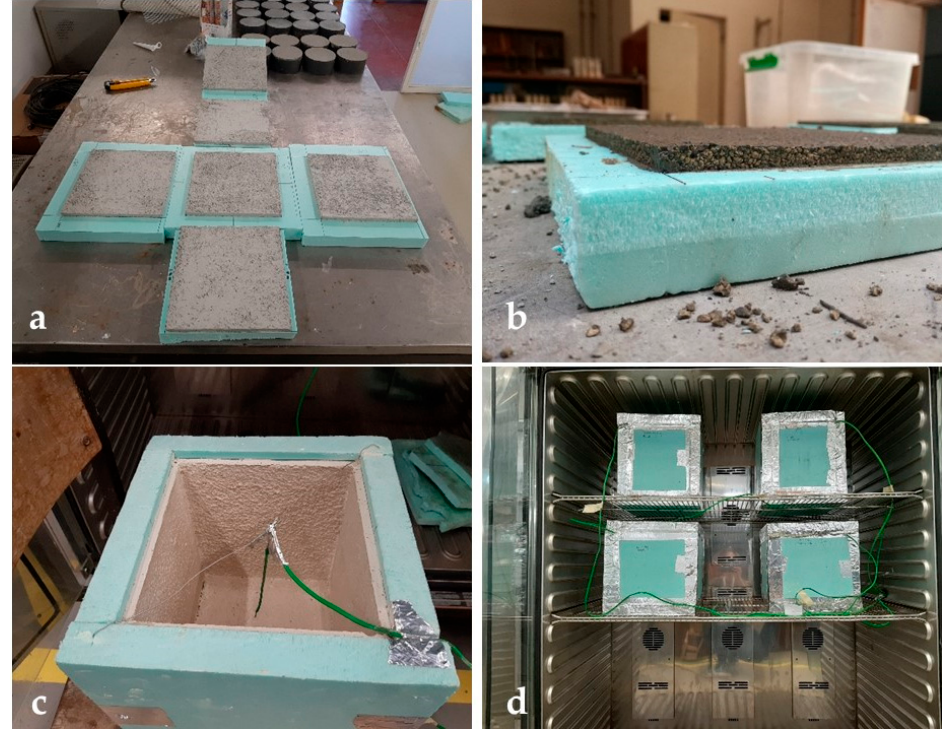
Figure 1. set up to investigate the thermal performance of the different mortars: ( a ) six faces to build a small-scale test cell; ( b ) mortar layer of 1 cm; ( c ) small-scale test cell with a thermocouple in the center; ( d ) small-scale test cells placed inside a climatic chamber with temperature control.